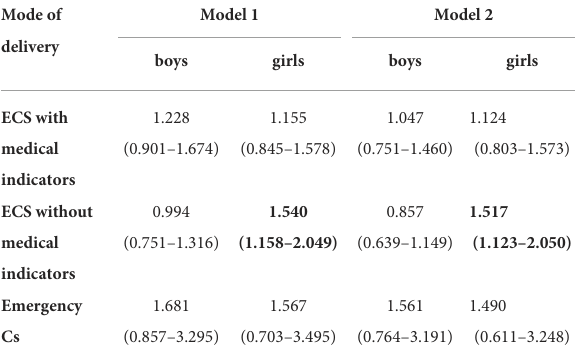
ECS with medical indicators